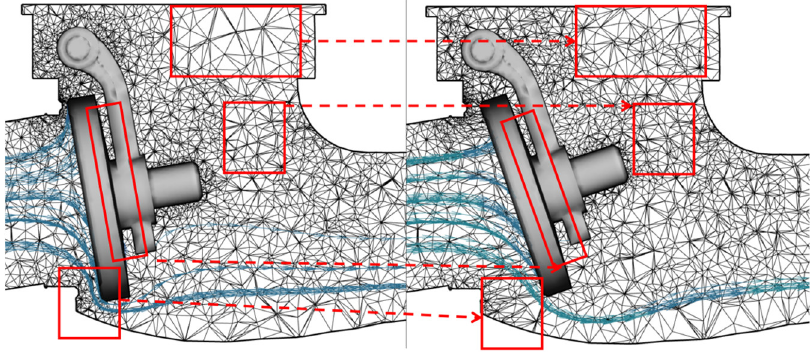
Figure 6. Opening process 3D passive-type dynamic mesh